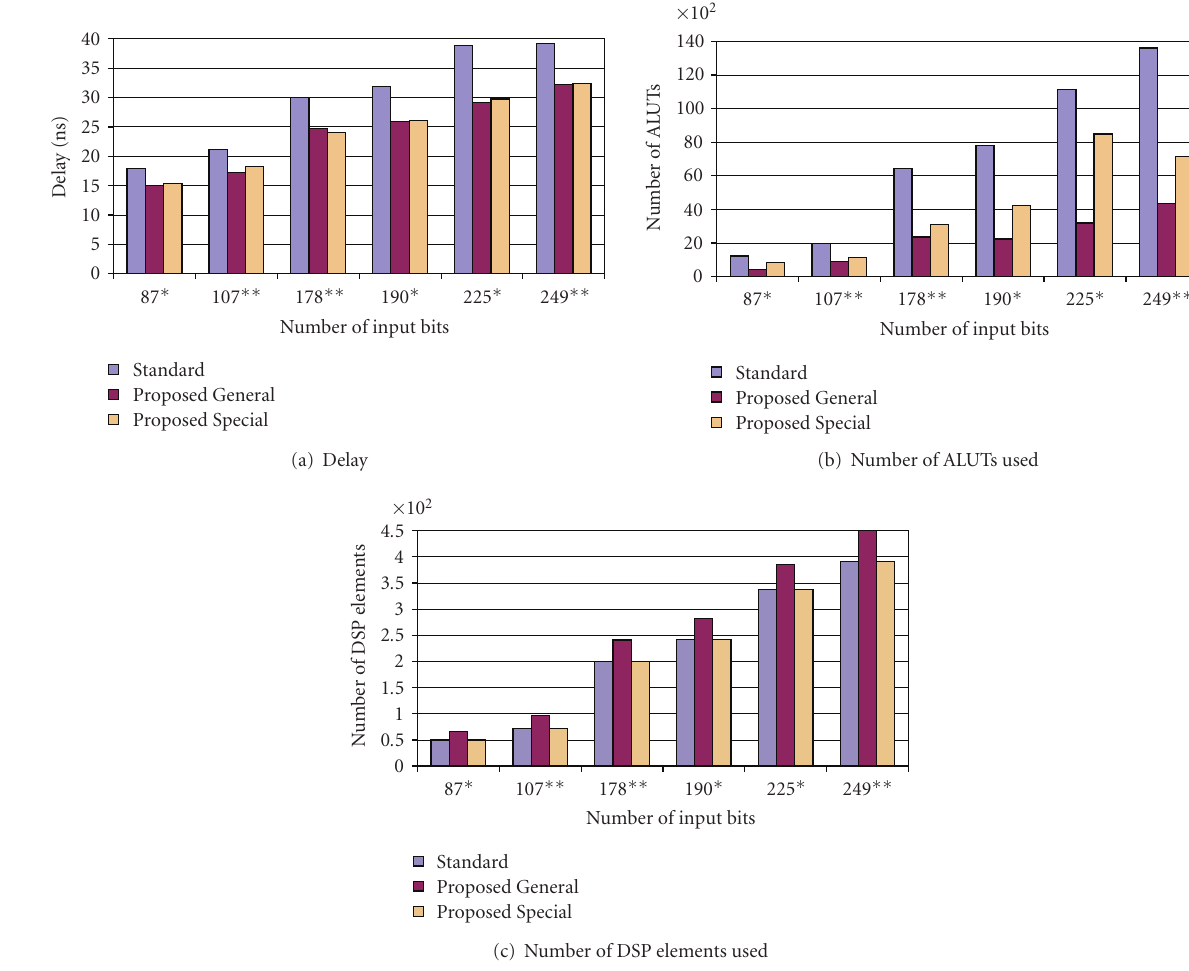
Figure 12: Result comparison for special